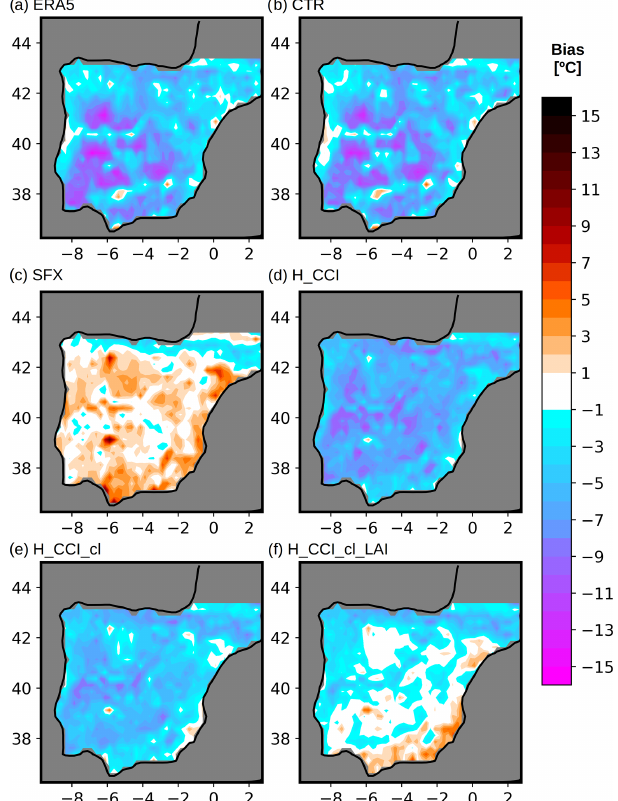
Figure 1. Maps of JJA daily maximum LST bias over Iberia under clear-sky conditions, computed for different simulations. (a) ERA5; (b) CHTESSEL offline (CTR); (c) SURFEX offline (SFX); (d) H_CCI; (e) H_CCI_cl; and (f) H_CCI_cl_LAI. LSA- SAF LST was considered as reference for computing the simulation